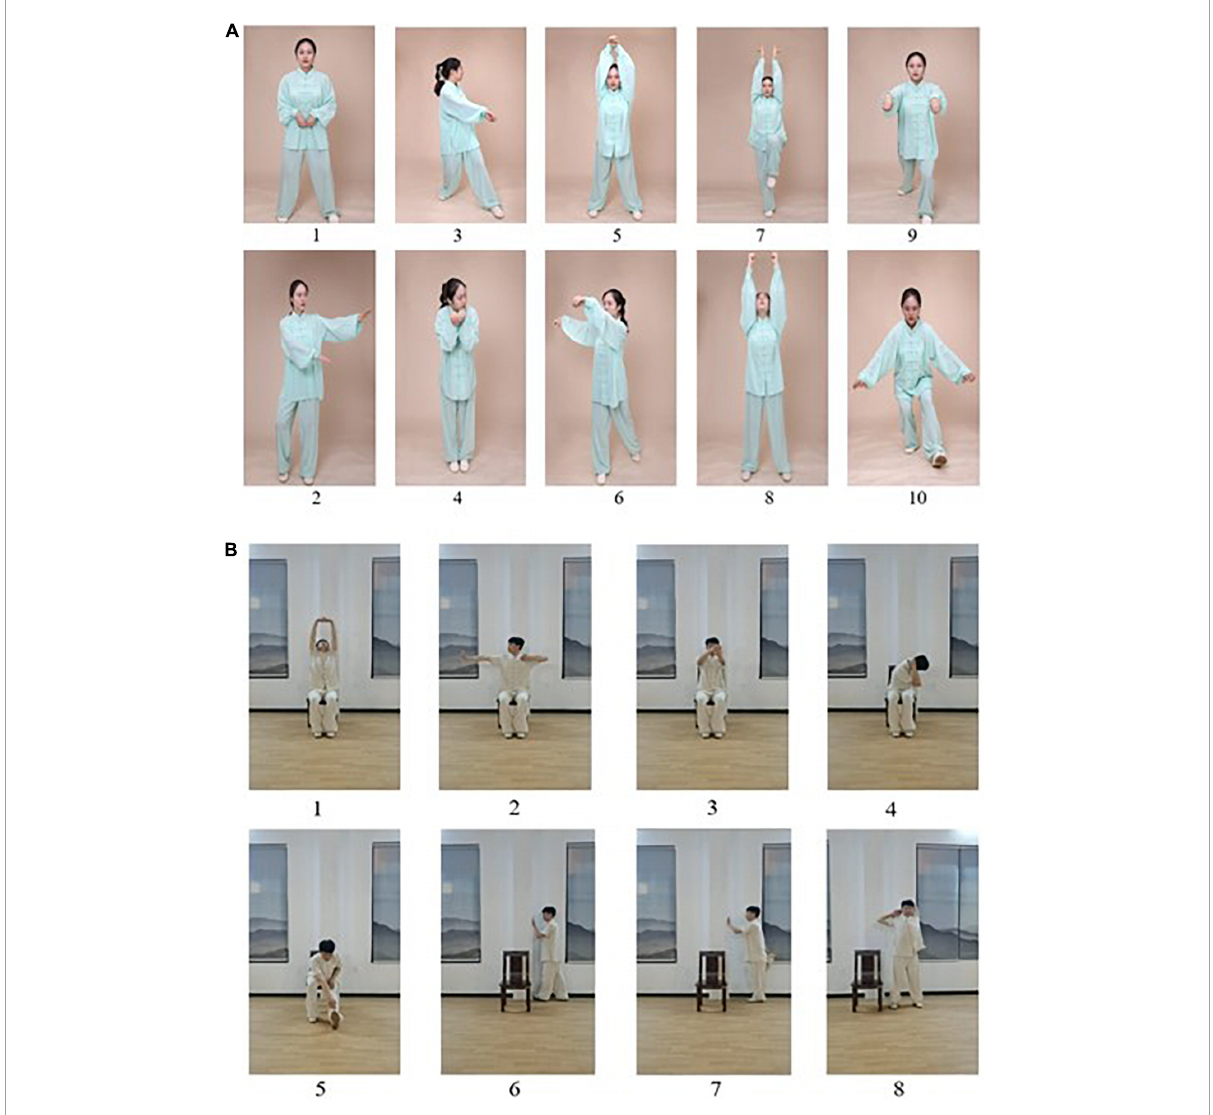
FIGURE2 Exercise maneuvers. (A) Wu Qin Xi , a commonly practiced traditional Chinese exercise, involves full-body movements in which one imitates (with two movements each) the movements and expressions of a tiger (1, 2), a deer (3, 4), a bear (5, 6), a monkey (7, 8), and a crane (9, 10). (B) The stretching intervention consisted of: (1) seated stretching up and down, (2) upper-limb stretching, (3) arm stretching, (4) torso stretching, (5) lower-limb stretching, (7) front thigh stretching, and (8) shoulder stretching.